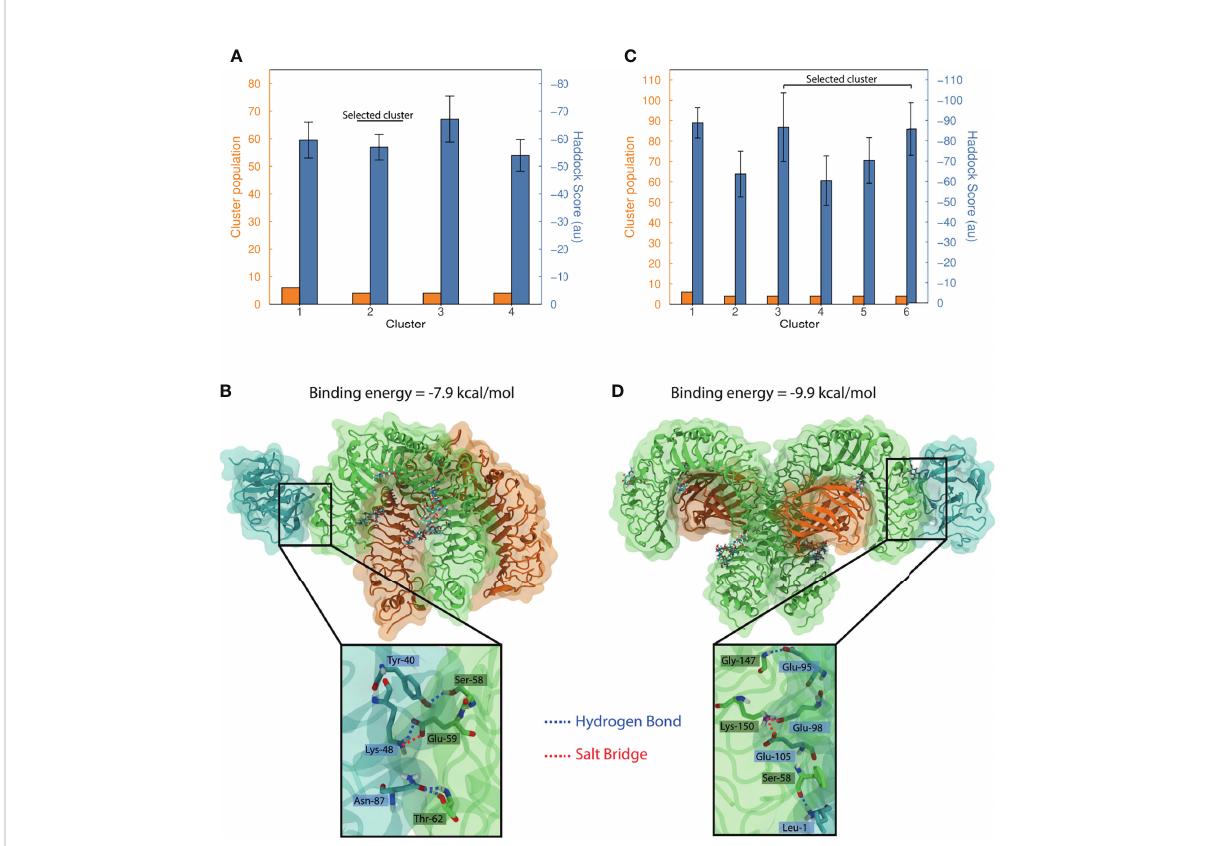
FIGURE 9 Protein docking of MEP_12 against TLR1/TLR2 and TLR4/MD-2. Bar plots summarizing the dockings (A) MEP_12-TLR1/TLR2 and (C) MEP_12- TLR4/MD2. The number of structures and the mean Haddock-score by cluster are shown in orange and blue, respectively. Whiskers in the mean Haddock-score bars represent one standard deviation. Structural representation of the most favorable binding mode of the cluster selected, of dockings (B) MEP_12-TLR1/TLR2, and (D) MEP_12-TLR4/MD2; showing the binding energy computed in PRODIGY. MEP_12 is colored in cyan; TLR1 and TLR4 in green; and TLR2 and MD2 in orange. Glycosylated residues and attached glycans (cyan) are shown as sticks, and non-carbon atoms are colored following the CPK convention. The inset plots show a closeup of the residues involved in polar interactions (as cyan and green sticks). The hydrogen bonds and salt bridges are represented by blue and red lines, respectively, connecting the interacting atoms which are labeled indicating amino acid and